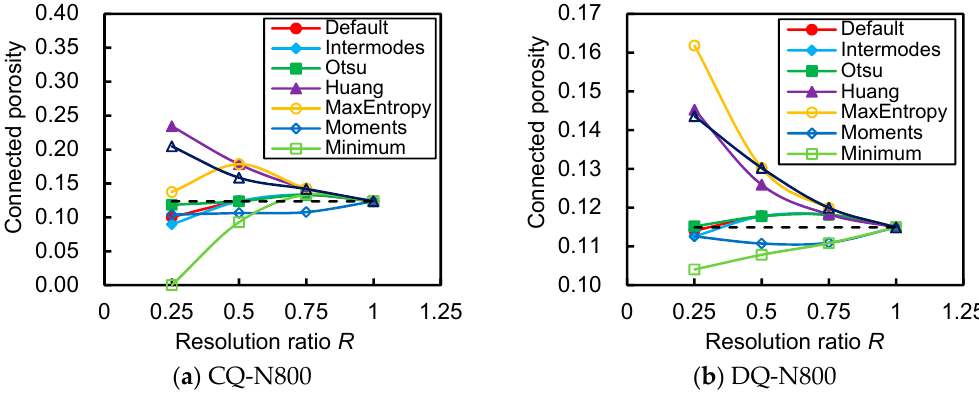
Figure A2. Influence on connected porosity of segmentation algorithm used in coarsening operation. Reference